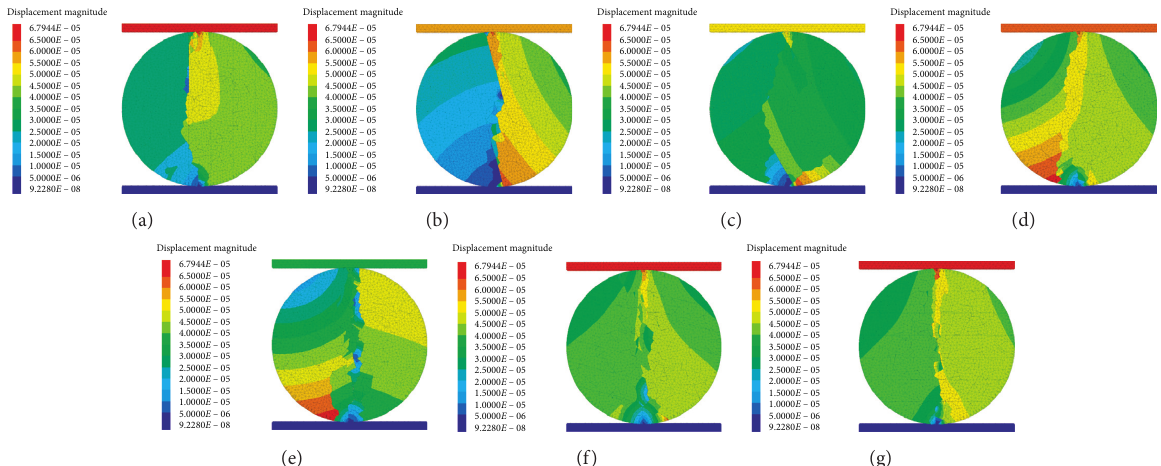
Figure 10: Cloud diagrams of loading displacement with uniform parallel bedding model at different angles. (a) 0 ° . (b) 15 ° . (c) 30 ° . (d) 45 ° . (e) 60 ° . (f) 75 ° . (g) 90 ° .